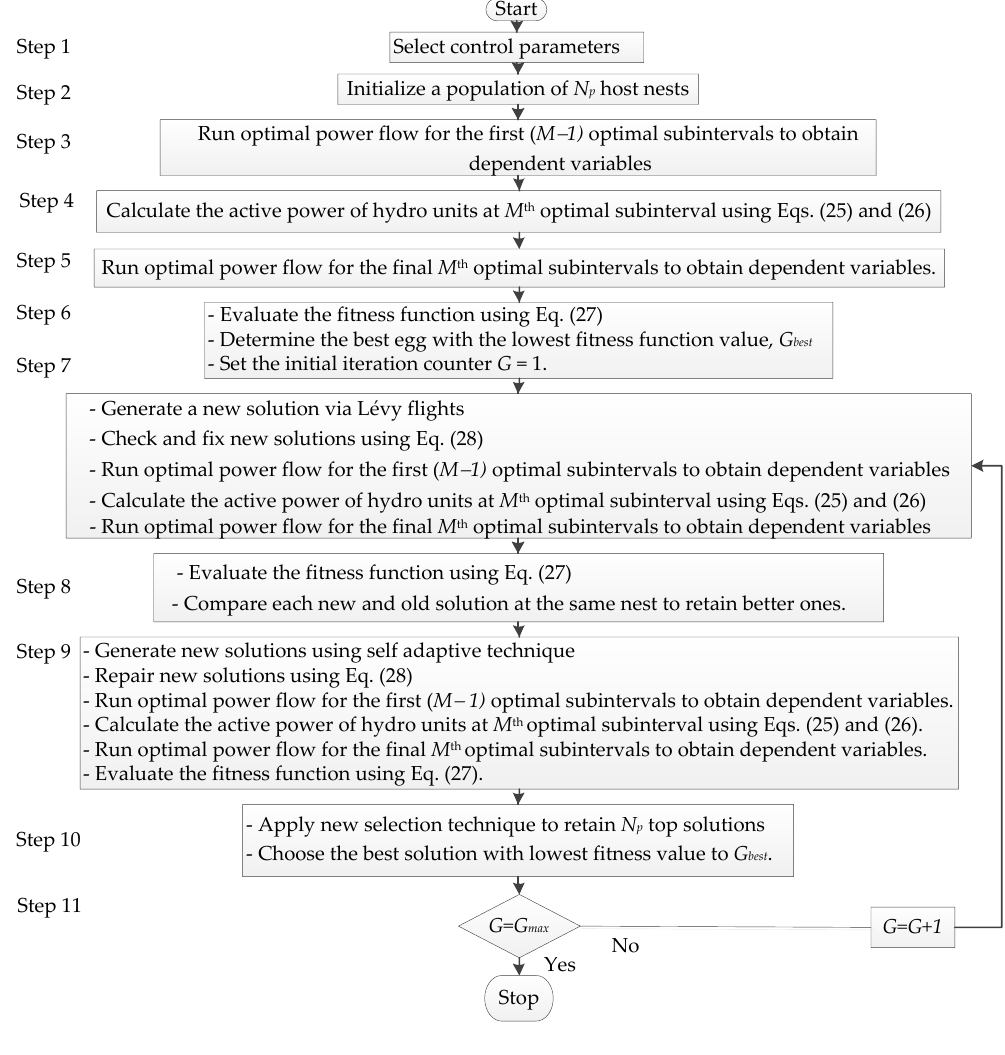
Figure 2. The flowchart of using the proposed method to solve the considered problem.